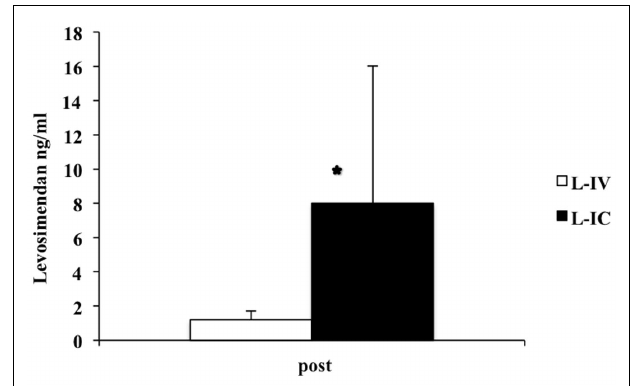
FIGURE 4 | Levosimendan concentrations at the end of the experiment in the left ventricular myocardial samples. L-IV, levosimendan infusion–group; L-IC, intracoronary levosimendan-group. * p = 0.001.